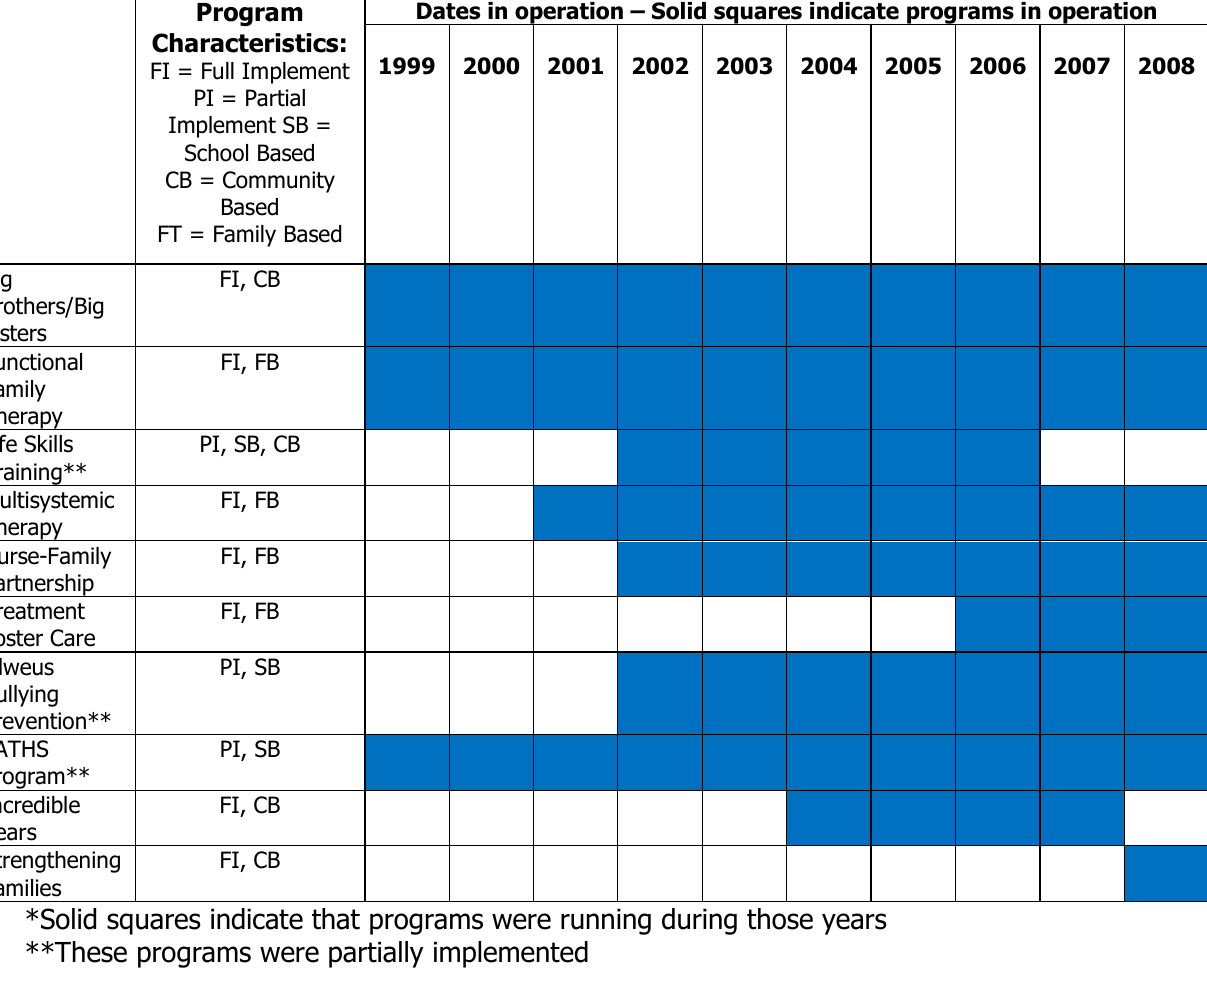
Implementation dates of evidence-based